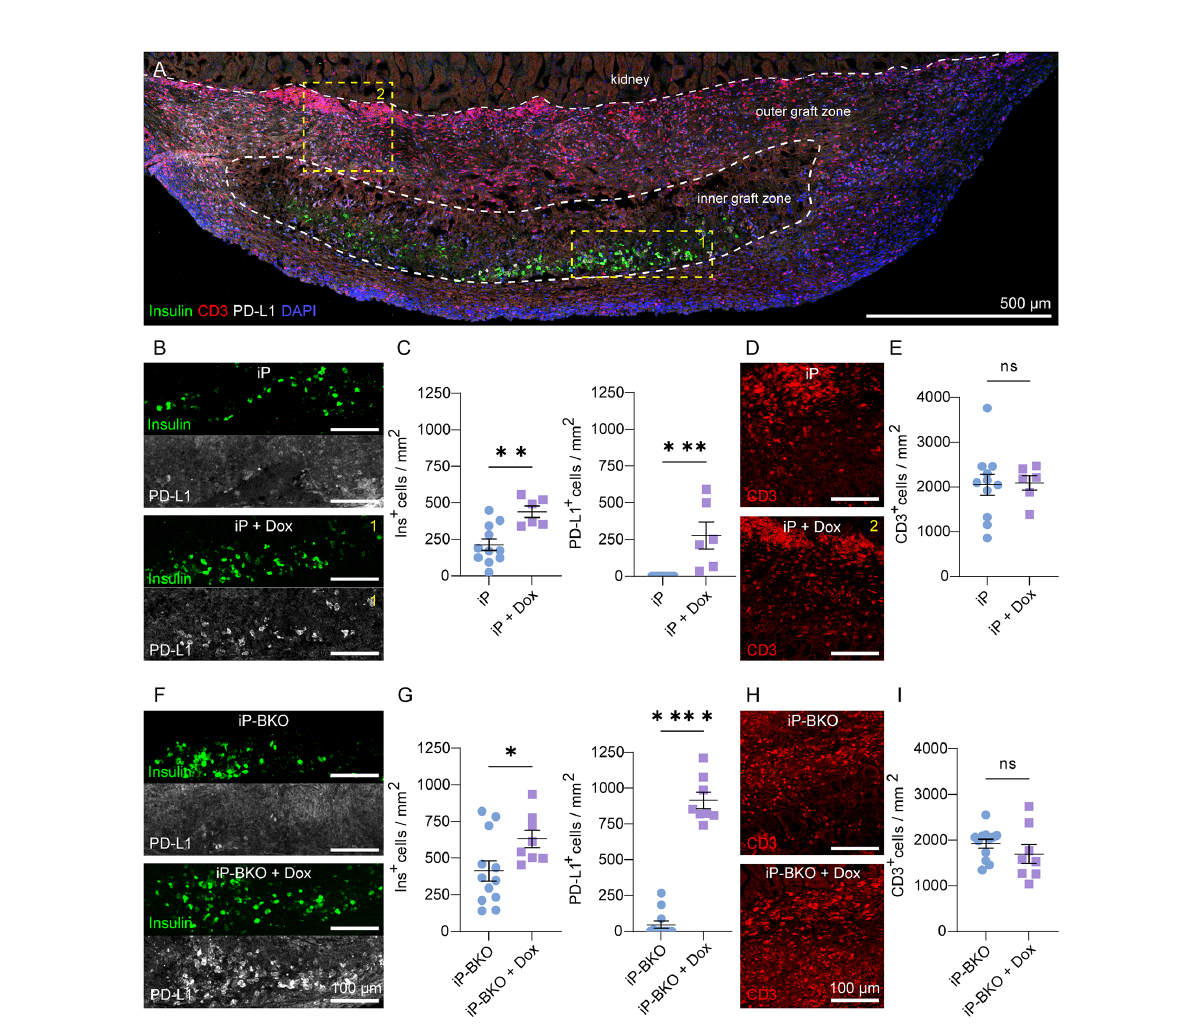
FIGURE 4 Insulin and PD-L1 expression by sBCs 2-weeks after transplantation. (A) Representative maximum intensity projection (MIP) image of whole graft-bearing kidney tissue section from the iP-sBC +DOX group immunostained for insulin, PD-L1 and CD3. (B, C) Expression and quanti fi cation of insulin and PD-L1 by iP and iP + DOX sBCs in inner graft zone. (D, E) Representative images and quanti fi cation of CD3 + cells in the outer graft zone of iP and iP + DOX sBCs. (F, G) Expression and quanti fi cation of insulin and PD-L1 by iP-BKO and iP-BKO + DOX sBCs in inner graft zone. (H, I) Representative images and quanti fi cation of CD3 + cells in the outer graft zone of iP-BKO and iP-BKO +DOX sBCs. The inner and outer graft zone in (A) are indicated with white dashed line and the regions enclosed in yellow dashed line depict location in the graft-bearing kidney from which the high magni fi cation images shown of insulin and PD-L1 (B) or CD3 (D) were taken. n = 8 to 12 immunostained 10 m m thin sections of 2 to 4 recovered graft-bearing kidneys per condition, from which graft was successfully located. Two- tailed Student ’ s t-test, *p = 0.0394, **p = 0.0023, ***p = 0.0008, ****p < 0.0001, mean ± s.e.m. ns, Not signi fi